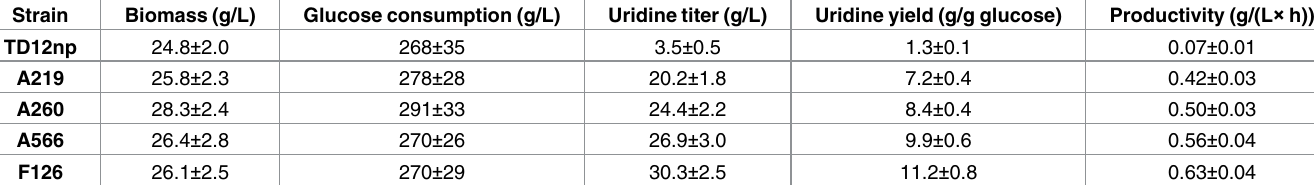
Table 3. Fermentation parameters of parent and mutant strains in 48 h fed-batch fermentation. Strain Biomass (g/L) Glucose consumption (g/L) Uridine titer (g/L) Uridine yield (g/g glucose) Productivity (g/(L × h))